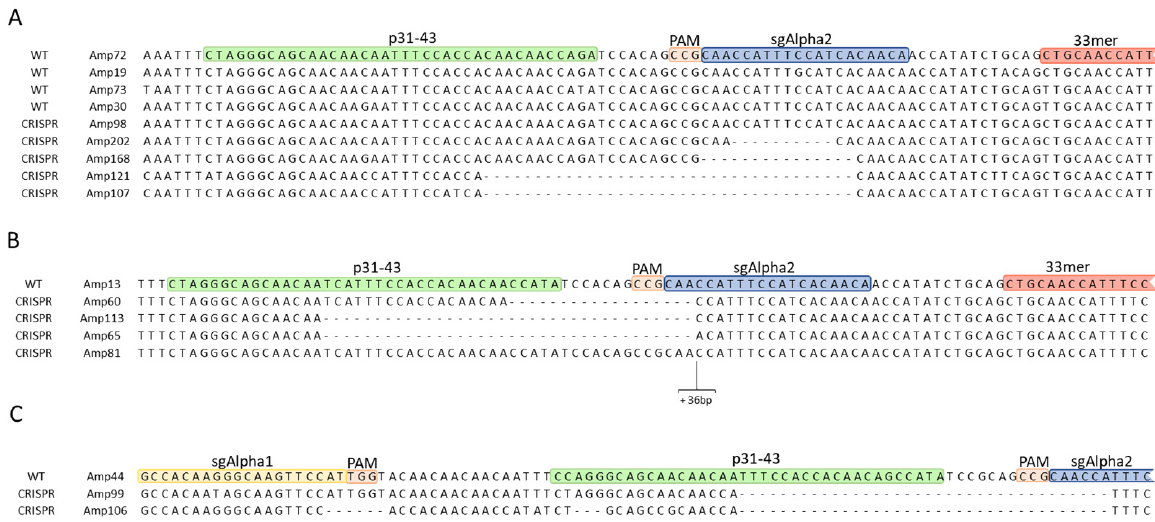
Figure 4. MUSCLE alignment of Amps clusters from the neighbor-joining dendrogram. ( A ) Cluster 1 of Amps present in lines with DP genotype. ( B ) Cluster 1 of Amps present in lines with BW208 genotype. ( C ) Cluster 22 of Amps present in lines with BW208 genotype. DP: Don Pedro. Amps: unique denoised amplicons.